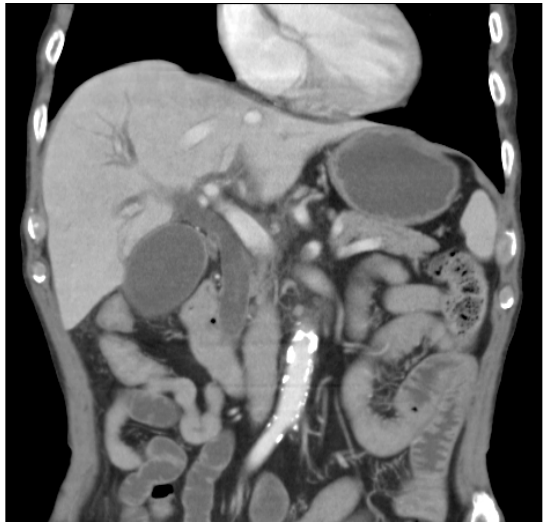
Figure 1. A 74-year-old male with a high-grade CBD obstruction due to a non-calcified nodule in the distal CBD orifice, which was highly indicative of bile-duct cancer. The pathology indicated intestinal